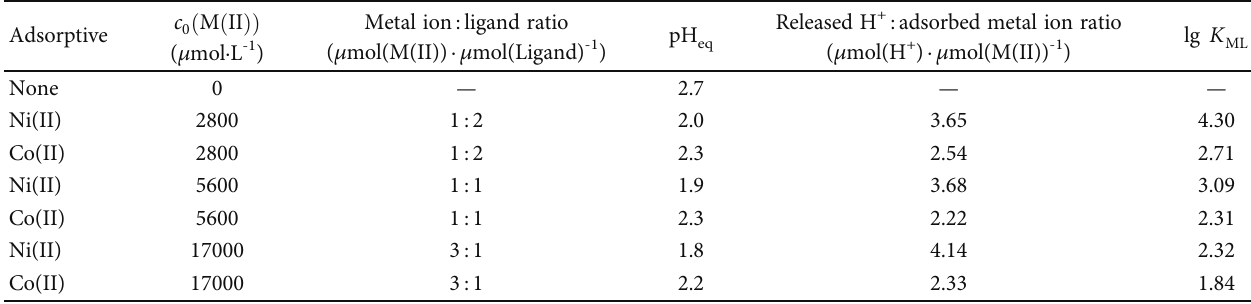
Table 3: Correlation between proton release per adsorbed metal ion during adsorption and stability constant K component